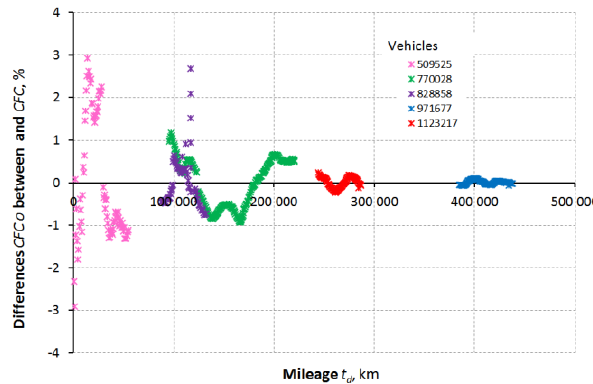
Fig. 6. Differences of CFC data from operation and calculation